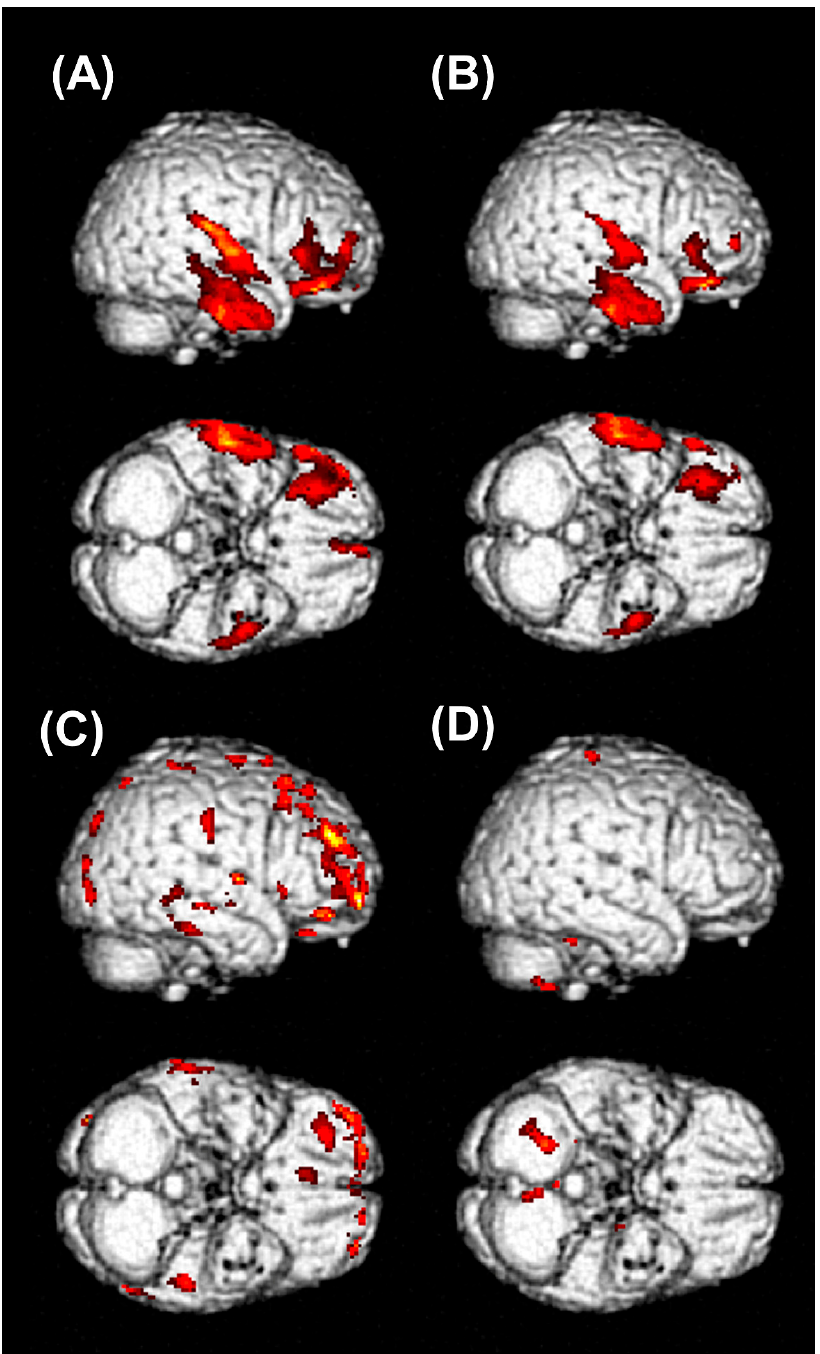
Figure 3. The result of individual analysis of brain FDG-PET/CT. The area colored red in the figure showed decreased FDG uptake in PET images of patients compared to the those of age- and gender-matched healthy control group. ( A ) The results of an initial brain FDG-PET in a 67-year-old man showed decreased glucose metabolism in an inferior area of the right frontal cortex and right temporal cortices. ( B ) On follow-up brain FDG-PET images 6 months after intoxication, decreased glucose metabolism in the right frontal and temporal cortices was persistently observed. ( C ) The results of an initial brain FDG-PET in a 57-year-old man showed decreased glucose metabolism in the right frontal cortex. ( D ) On 2 months follow-up brain FDG PET images, decreased glucose metabolism in the right frontal cortex was almost recovered. ( A , B ) Compared to the age of approximately 60 years and male normal healthy subjects ( n = 16). ( C , D ) Compared to the age of approximately 50 years and male normal healthy subjects ( n =